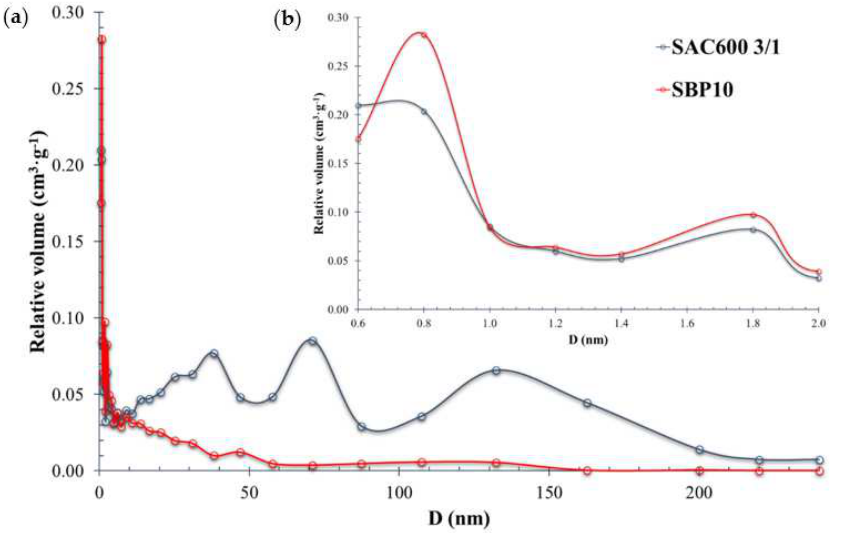
Figure 2. Nitrogen adsorption/desorption isotherms at 77 K on SAC600 3/1 and SBP10. The presence of micropores and mesopores in the material was confirmed by the HK (Horváth-Kawazoe) pore size distribution pattern [61]. Figure 3 shows the corresponding results.